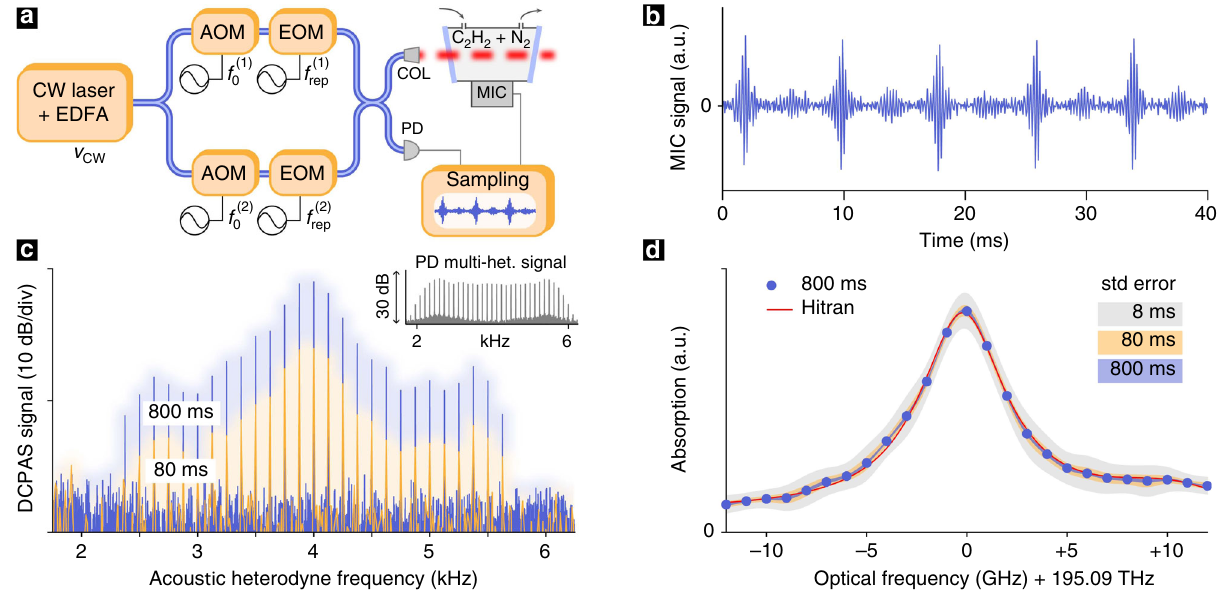
Fig. 2 Experimental setup and results. a Experimental setup for the photo-acoustic detection of gaseous acetylene (C 2 H 2 ). A tunable continuous-wave (CW) laser with optical frequency ν CW is ampli fi ed by an erbium-doped fi ber ampli fi er (EDFA) and used as a common seed for the generation of two optical frequency combs with repetition rates of f ð 1 Þ and f ð 2 Þ via electro-optic modulation (EOM). Acousto-optic modulation (AOM) of the CW laser with rep rep f ð 1 Þ and f ð 2 Þ controls the relative offset between both combs. (COL: free space collimator; PD: reference photo-detector MIC: low-noise MEMS microphone, 0 0 see Methods for more details). b Acoustic multi-heterodyne signal recorded by the microphone (5 interferograms; after high-pass fi ltering) for an acetylene fi lled cell. c Spectrum of the acoustic multi-heterodyne signal for 80 ms and 800 ms long acquisitions. Inset: Multi-heterodyne reference spectrum as recorded by the reference photo-detector (over the same span). d Acetylene absorption signature obtained after normalizing the acoustic multi-heterodyne spectrum by the reference spectrum for an 800 ms acquisition duration (blue dots); shaded areas (gray, yellow, blue) represent the standard-error intervals for different acquisition durations (8 ms, 80 ms and 800 ms). The red line shows the HITRAN model for